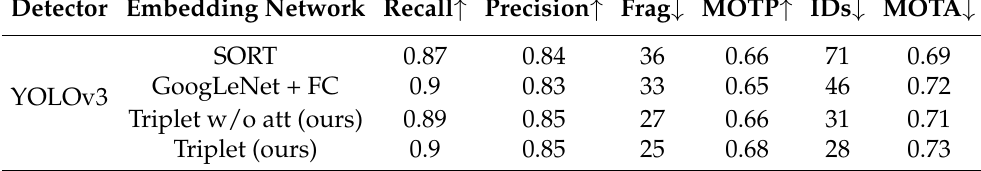
Table 3. Experimental results for embedding networks. The arrows indicate better performance for each metric. (i.e., down arrow—lower is better).